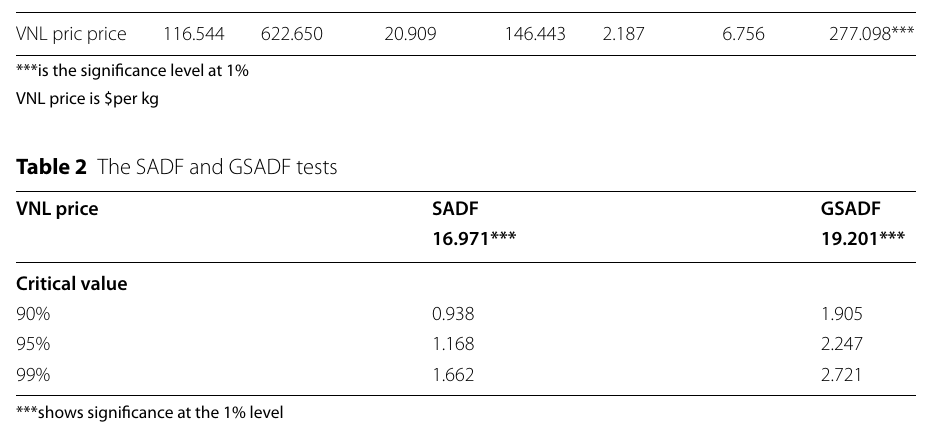
***shows significance at the 1% level